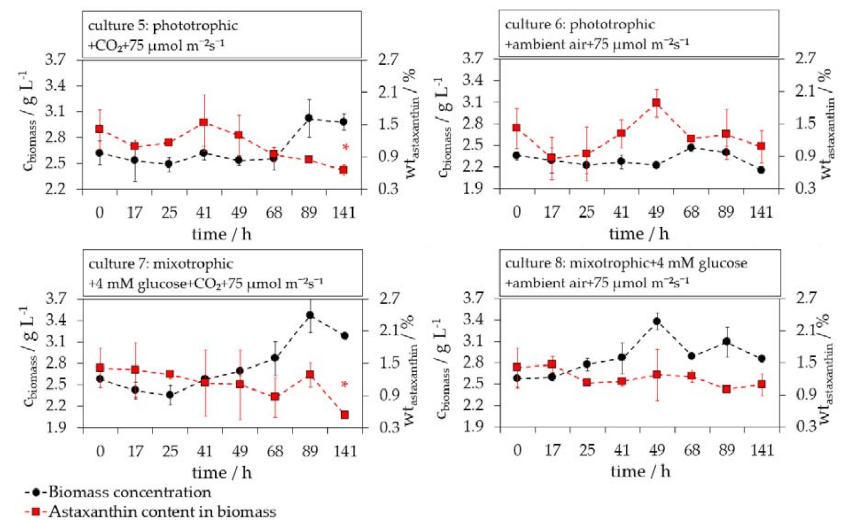
Figure 6. Time course of the biomass concentration and the astaxanthin content in the algal biomass of phototrophic culture 5 (phototrophic + CO2 + 75 µ mol m − 2 s − 1 ) and culture 6 (phototrophic + ambient air + 75 µ mol m − 2 s − 1 ), and mixotrophic culture 7 (mixotrophic + 4 mM glucose + CO2 + 75 µ mol m − 2 s − 1 ) and culture 8 (mixotrophic + 4 mM glucose + ambient air + 75 µ mol m − 2 s − 1 ). Biomass concentration: error bars show ± SD, n = 3. Astaxanthin content: error bars show ± SD, n = 3 at t = 0 h, t = 49 h, and t = 141 h and ± SD, n = 2 at t = 17 h, t = 25 h, t = 41 h, t = 68 h, and t = 89 h of one biological sample; asterisks indicate significant differences ( t -test) of measured value vs. control (t = 0 h) at p <